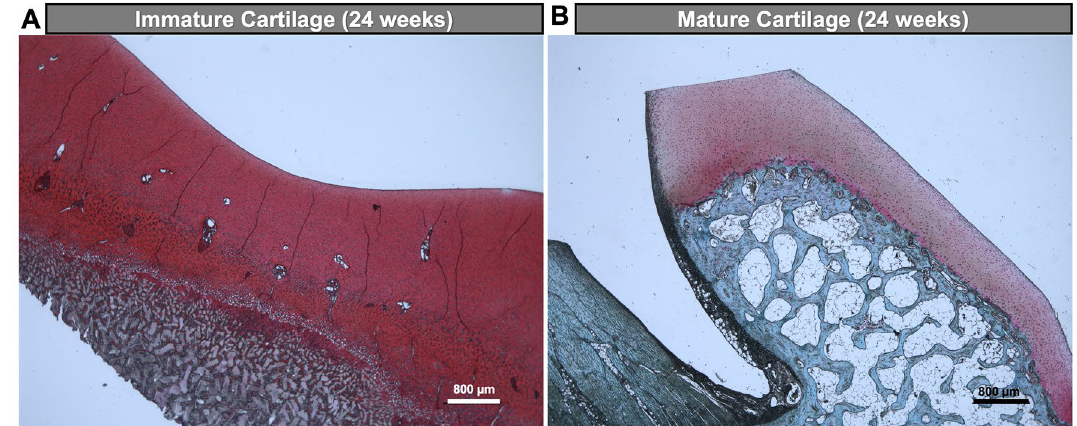
Figure 6. Histological analysis of cartilage repair in immature ( A ) and mature ( B ) pigs at 24 weeks after MASI (scale bars: 800 µm). Safranin O staining demonstrates the presence of microvasculature in the cartilage of immature pigs ( A ) while no vessels were identified in mature pigs’ cartilage ( B